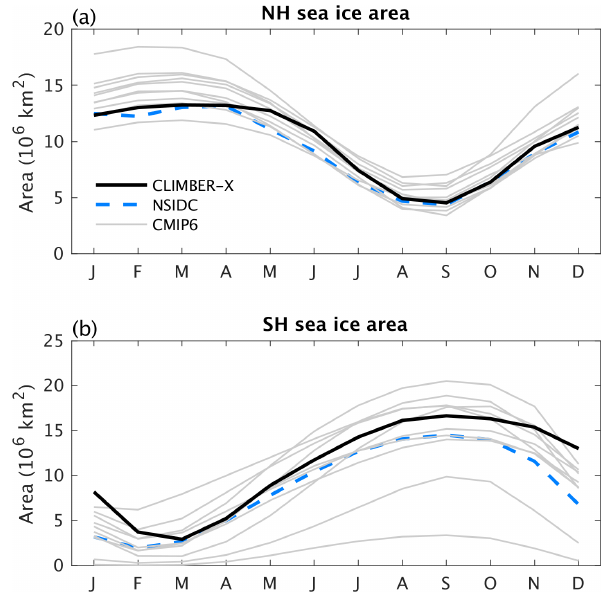
Figure 16. Seasonal variation of total sea ice area for (a) the NH and (b) the SH as simulated by CLIMBER-X (black) compared to observations (Meier et al., 2021) (blue) and CMIP6 models